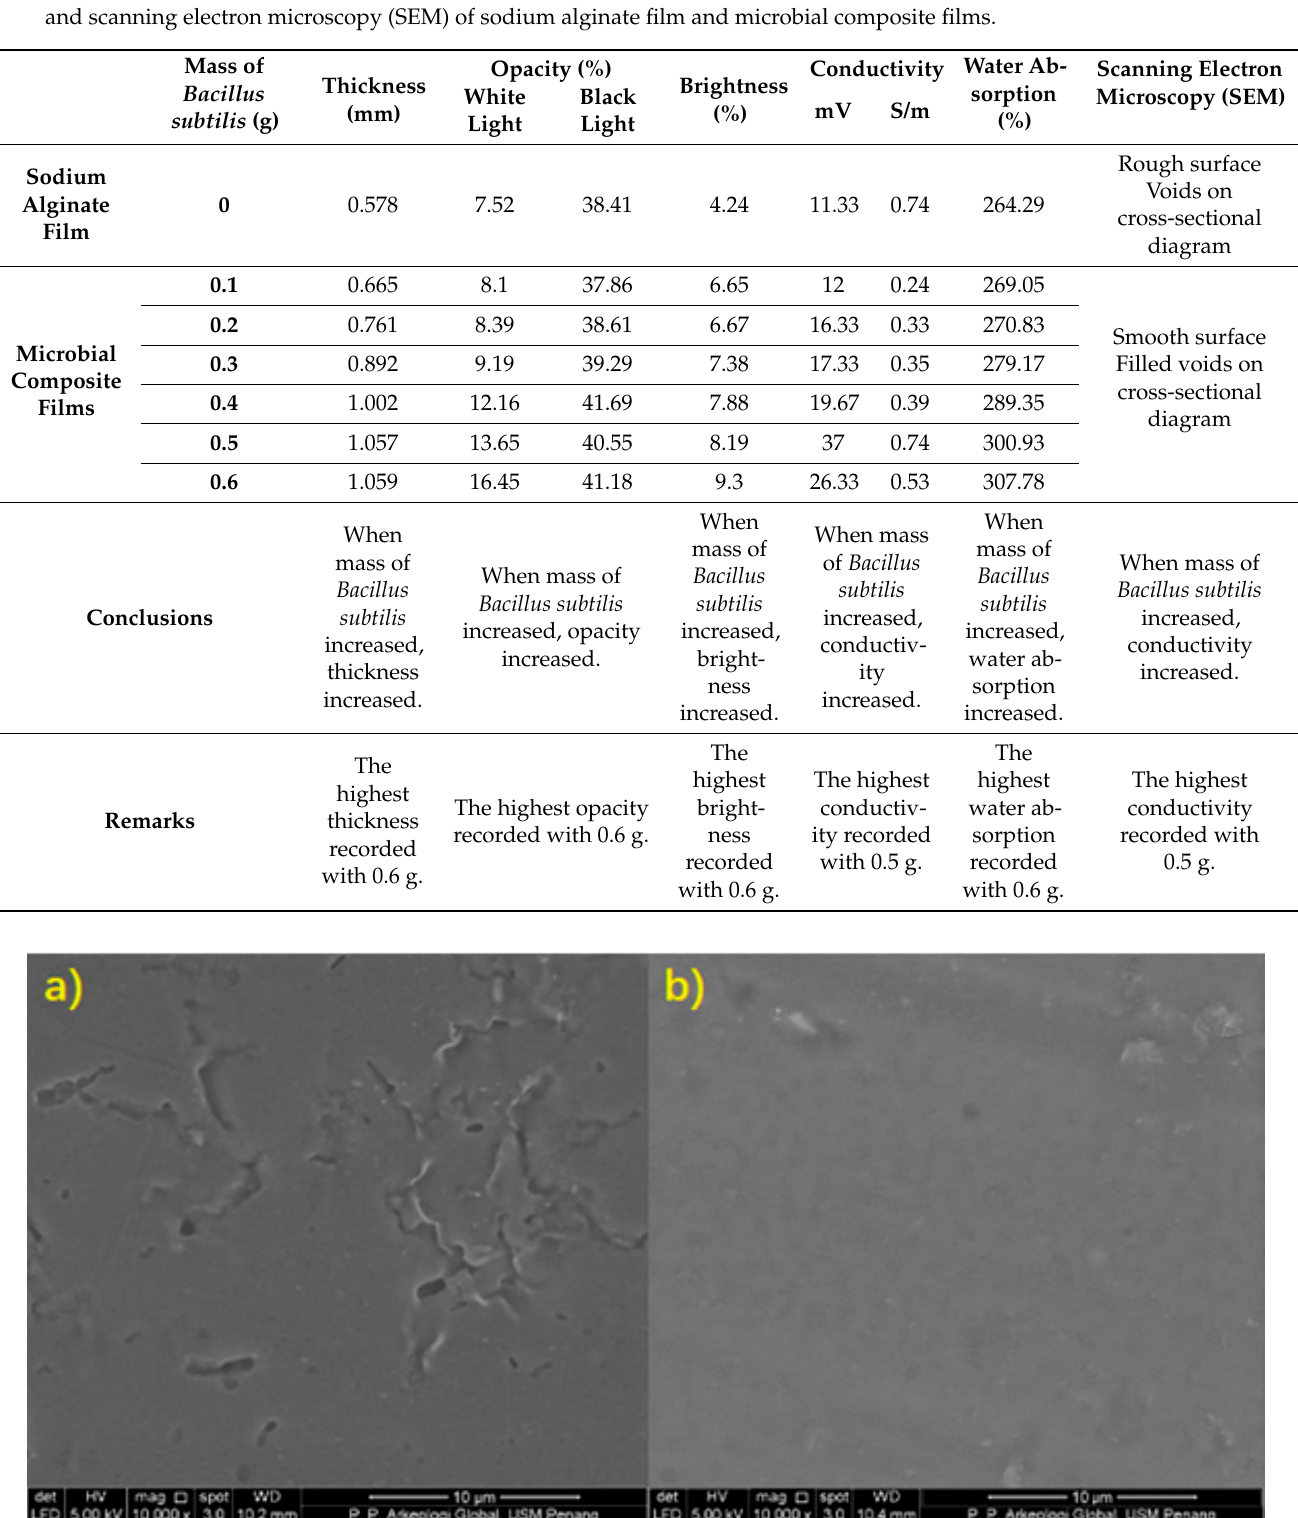
Figure 6. Surface scanning electron microscope (SEM) image of ( a ) sodium alginate film and ( b ) 0.5 g microbial composite film.